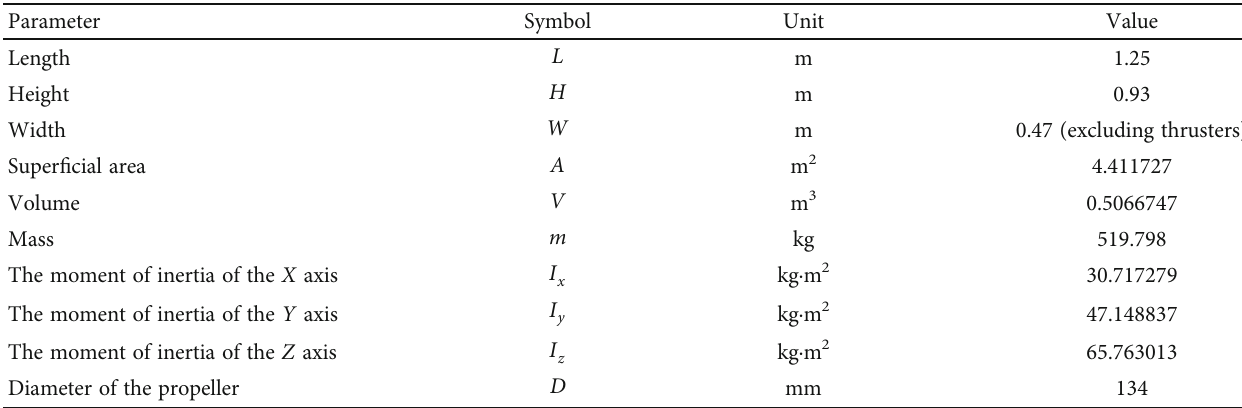
Figure 1: The Lingyun: (a) 3D model of the Lingyun; (b) Lingyun in the Mariana Trench. Table 1: Parameters of the